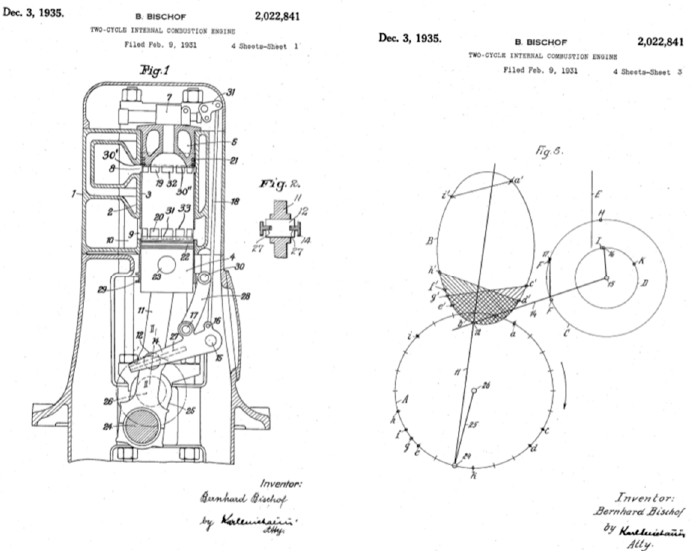
Figure 7. B. Bischof, 9 February1931, two-stroke internal combustion engine US 2022841.